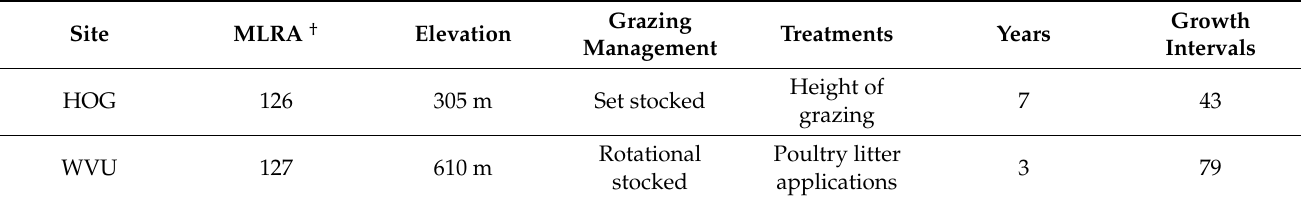
Table 2. Environment and management of sites where pasture growth was measured. Site Treatments Years